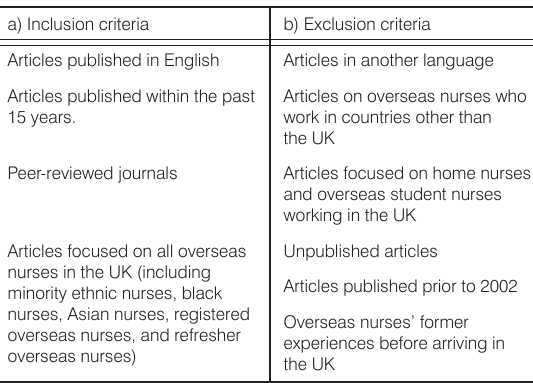
Figure 1. Foreign nurses working in the UK. Source: Nursing and Midwifery Council – Title: Recruiting foreign nurses